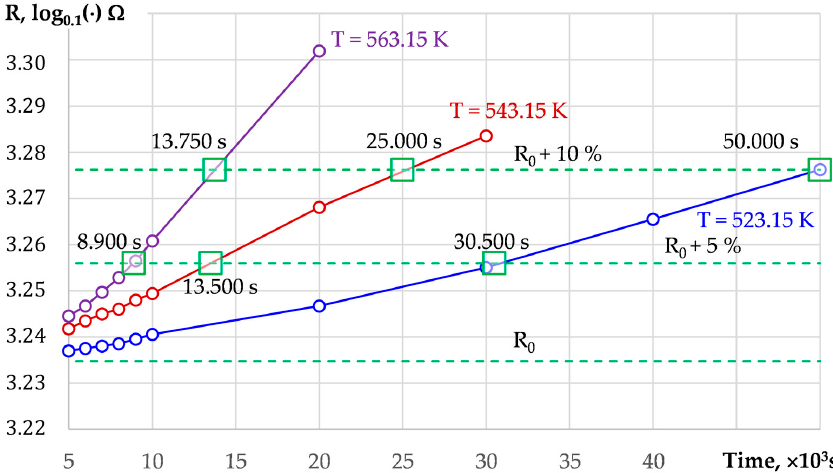
Figure 4. The time dependence of resistance at LRS and high temperatures.